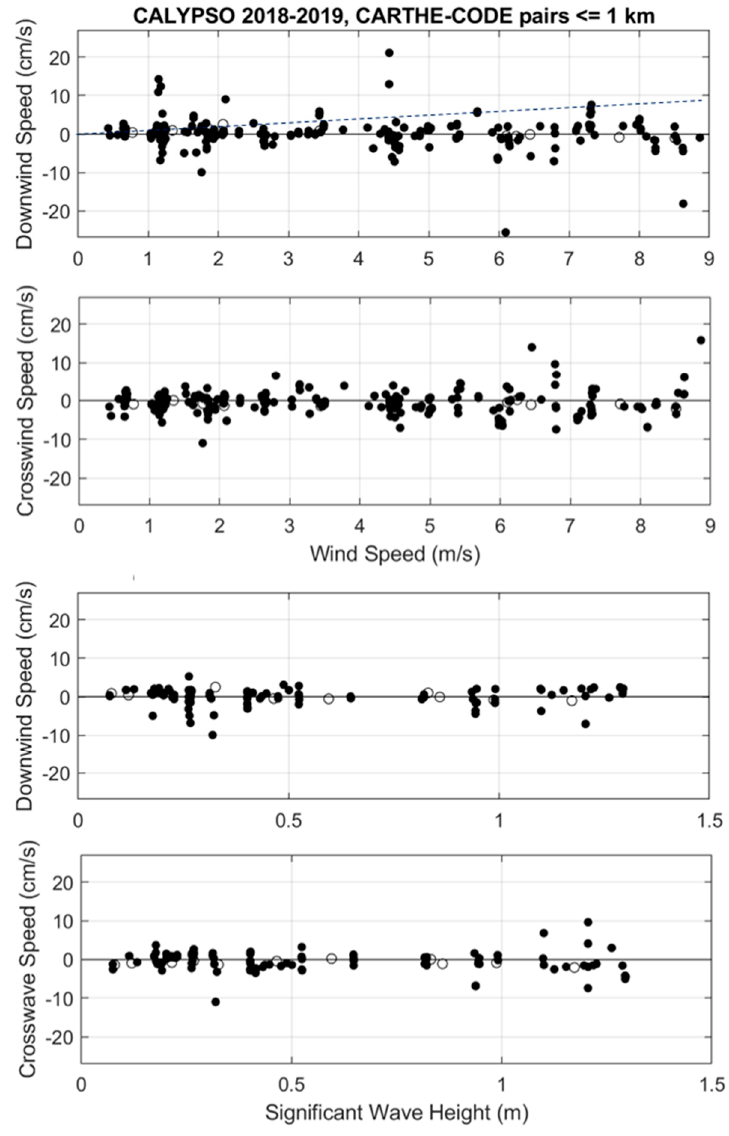
Figure 4. Down- and cross-wind components of velocity difference between CARTHE and CODE drifters versus ERA5 wind speed ( top panels ) and significant wave height ( bottom panels ): CA- LYPSO 2018 (black dots) and CALYPSO 2019 (circles). The 1% slope is shown as a dashed line in the top panel for reference.